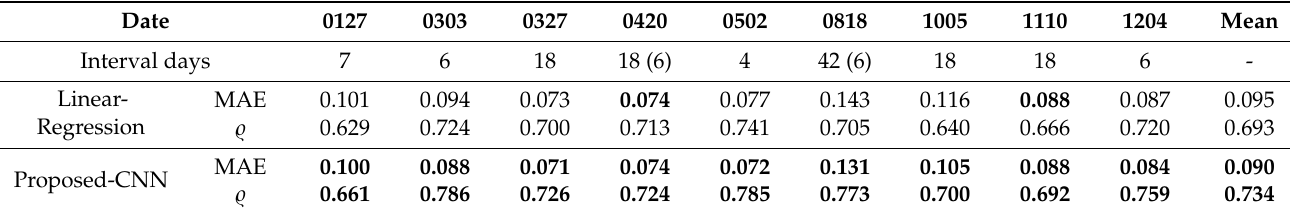
Table 2. Quantitative results for the target area. Dates are the acquisition dates for Sentinel-1. Interval days show the interval between the date of available imaginary from 2019 and the equivalent day in 2020. Calculated interval days including partly available data (images with clouds) are shown in parenthesis. Bold numbers represent best results for each